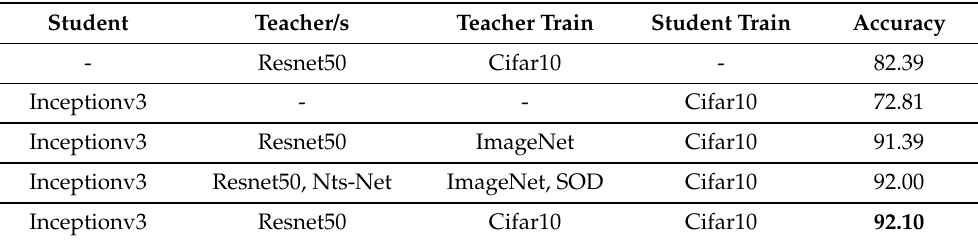
Table 5. In this Table, we report the results using an InceptionV3 model on Cifar10 with a Resnet50 teacher model trained on ImageNet or trained on Cifar10 (200